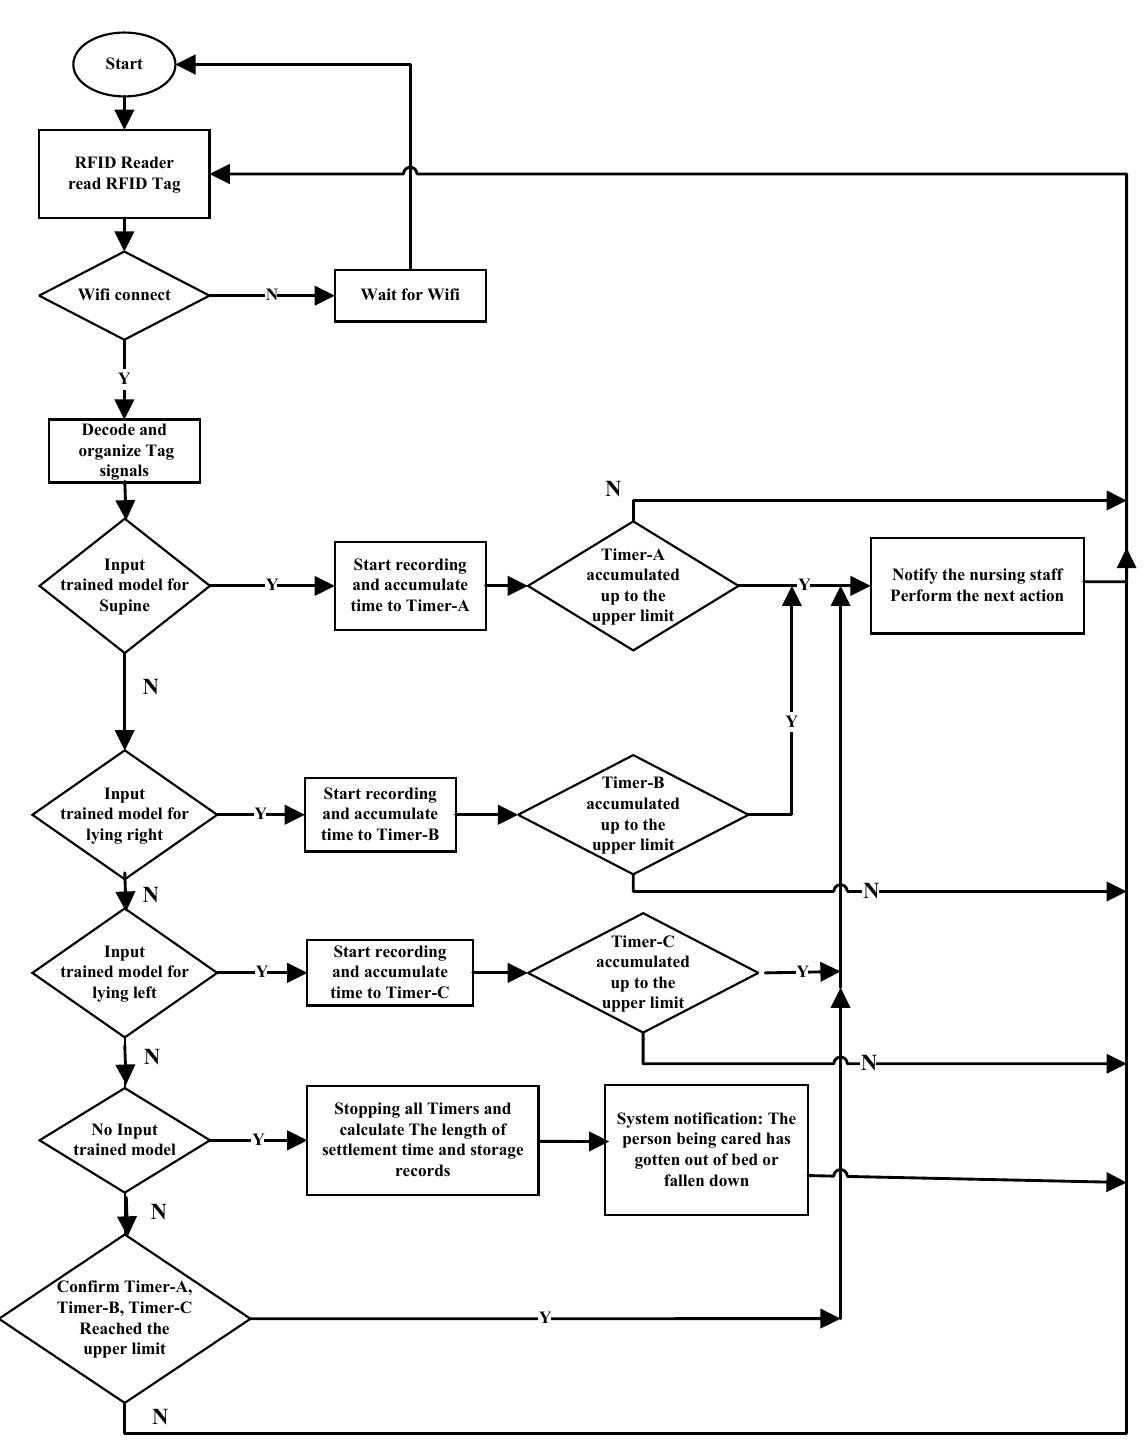
Figure 5. Flowchart of the proposed system.